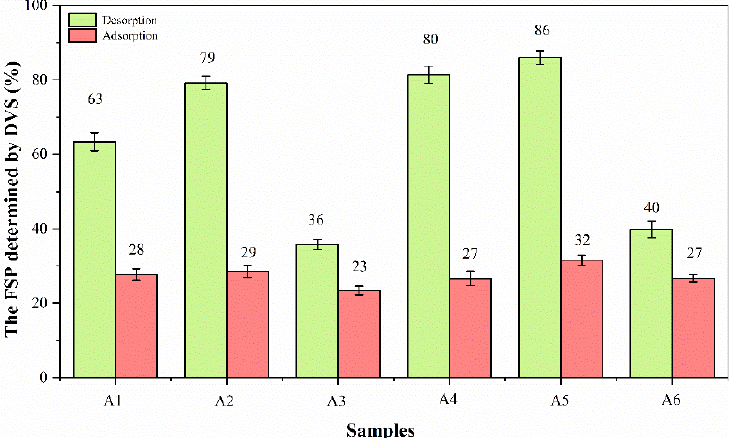
Figure 7. The dynamic sorption of water vapor (DVS) determined fiber saturation point (FSP) of waterlogged archaeological wood.